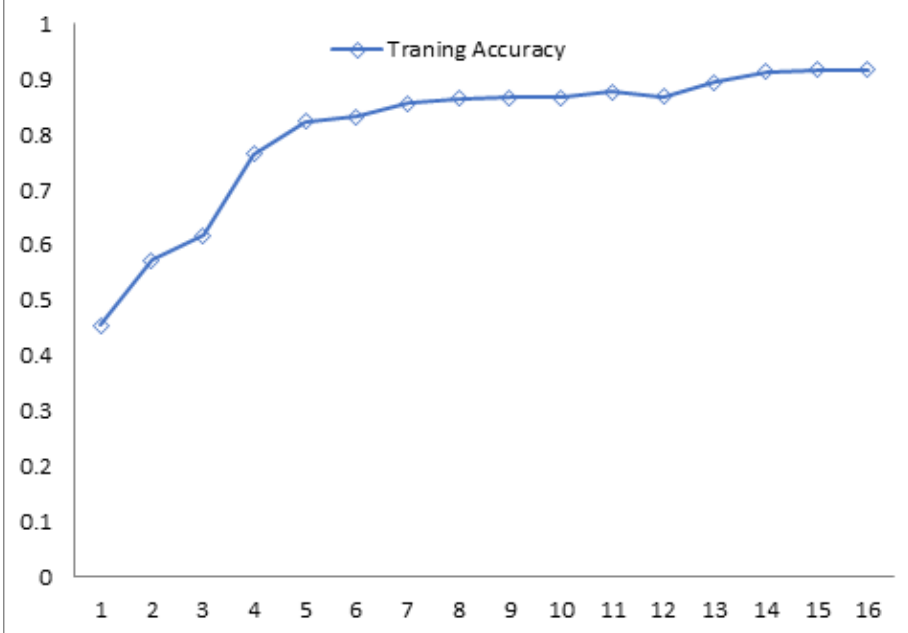
Figure 4. Evaluation of the training